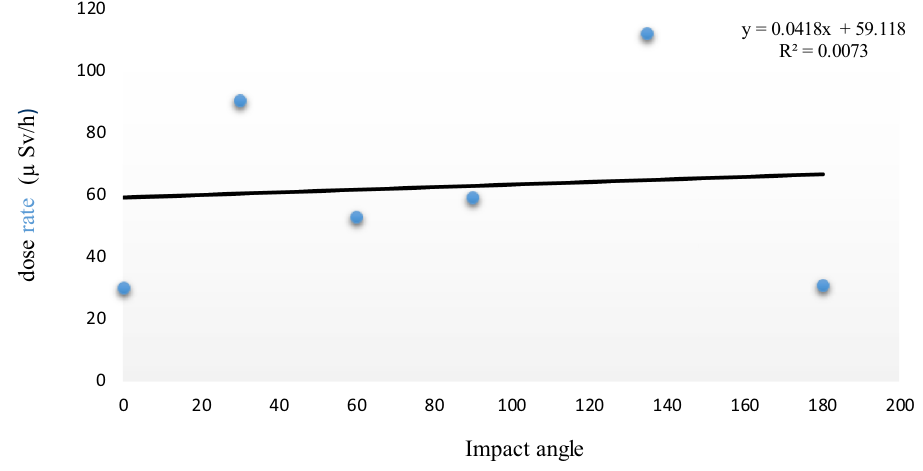
Figure 7. Dose rate (µSv/h) recorded by the RadioactivityCounter app versus incidence angle (degree).